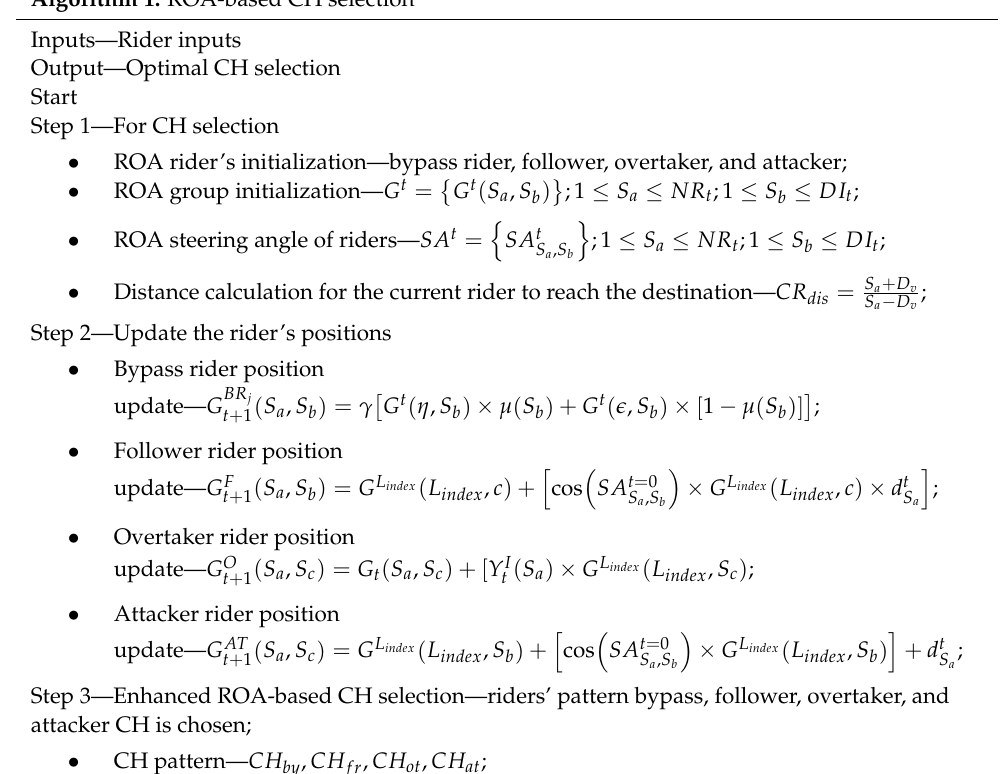
Algorithm 1. ROA-based CH